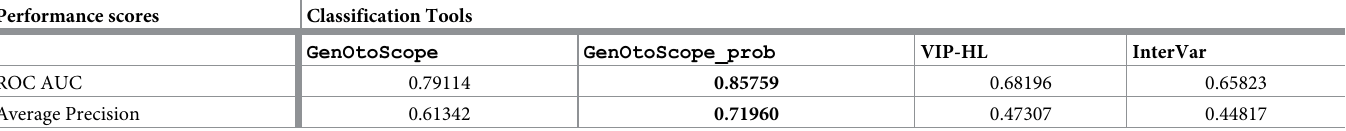
Table 2. Micro-averaged performance scores for all classification tools, over the three broader classes in the VCEP-HL data set. Best values of a performance score, across all classification tools, are shown in bold. Performance